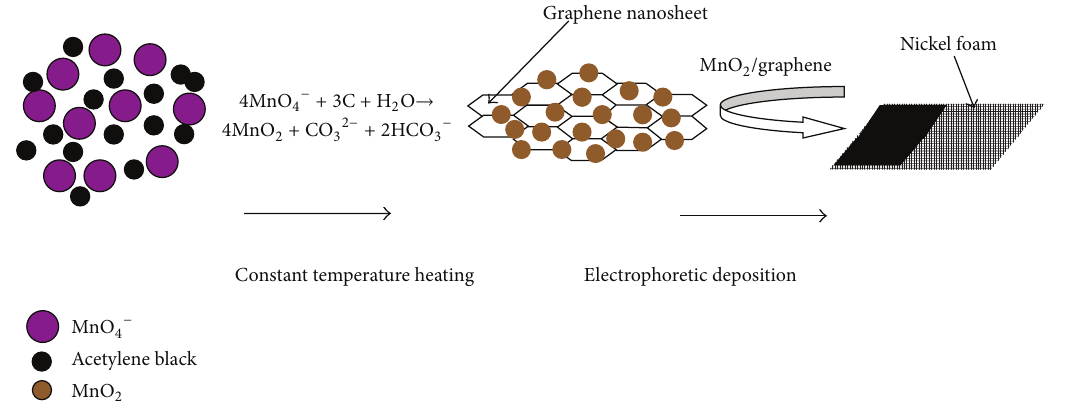
Figure 2: The fabrication procedure of MnO 2 /graphene